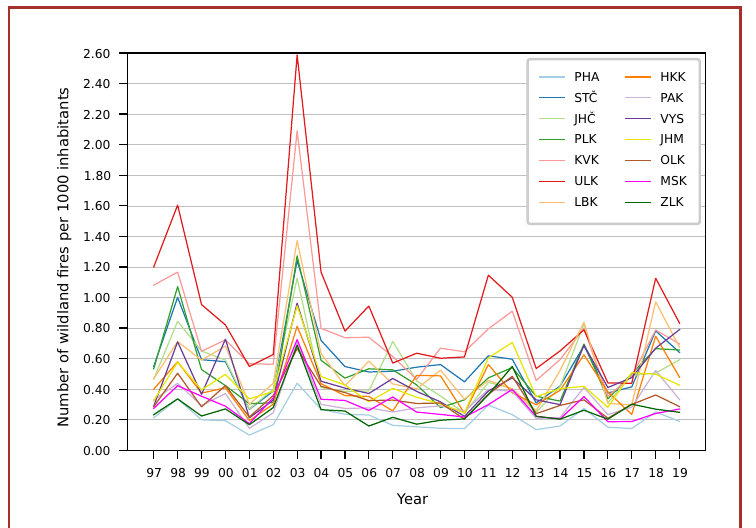
Figure 5. Time-series of wildland fires per 1000 inhabitants in 14 regions of the Czech Republic, including the Capital City of